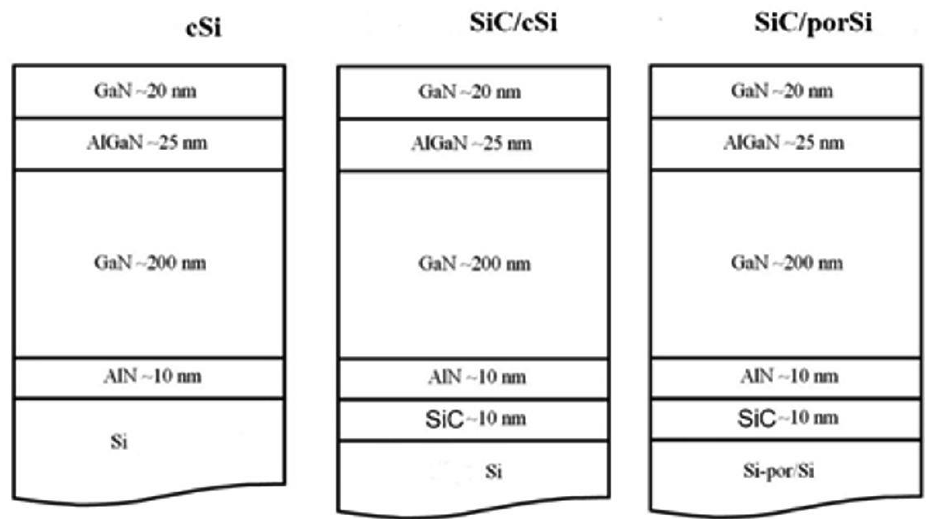
Figure 1. Design of the investigated heterostructures.